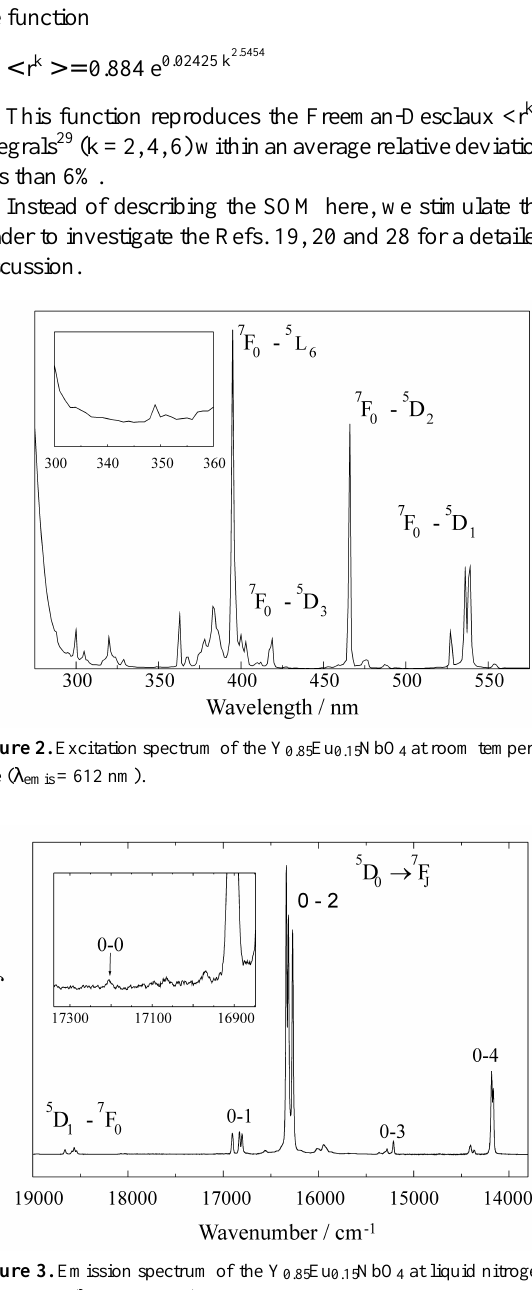
Figure 1. Excitation spectrum of the YNbO 4 at room temperature ( l emis = 410 nm).